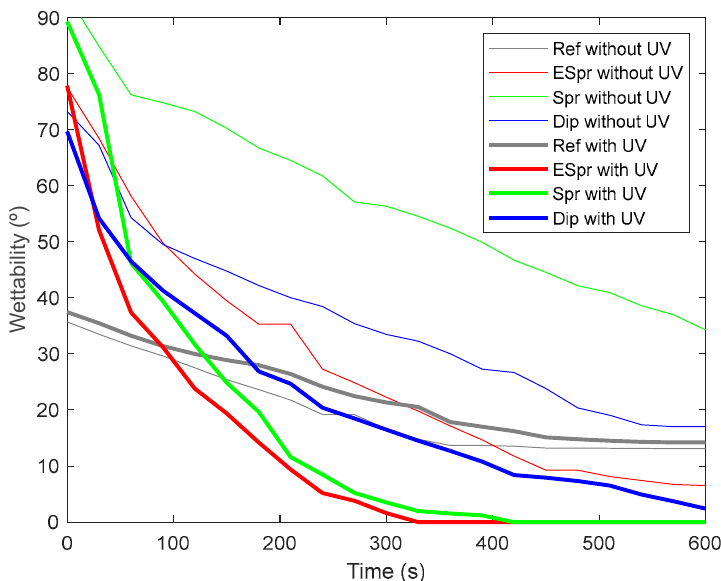
Figure 7. Water drop contact angle decreases results with and without UV incidence to the functional area of the water drop, along a total time of 10 min.